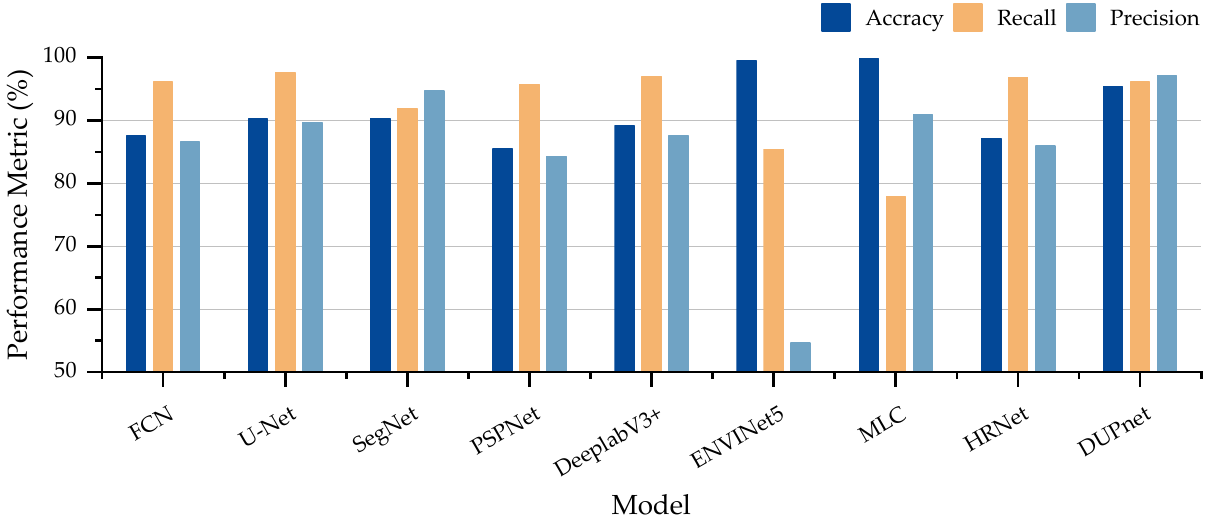
Figure 9. The histogram of quantitative comparison of different models in terms of Accuracy, Precision, and Recall (%) on the LR dataset.